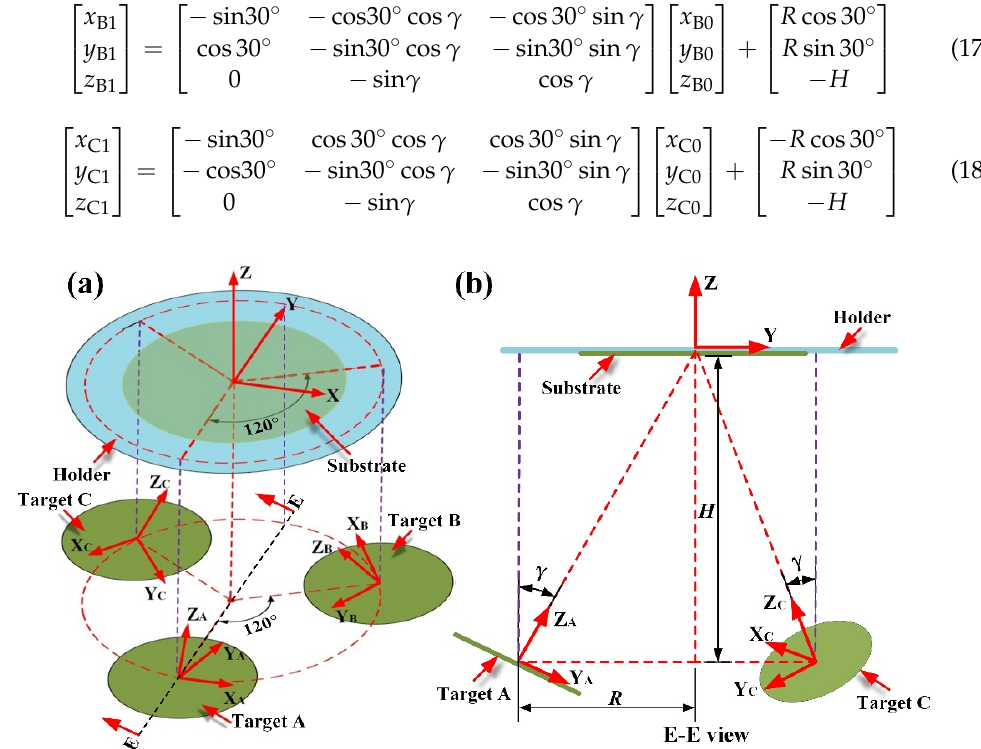
Figure 2. Target-substrate geometric configuration of a triple-target magnetron co-sputtering system: ( a ) Isometric view; ( b ) Projected view through E-E cross section.